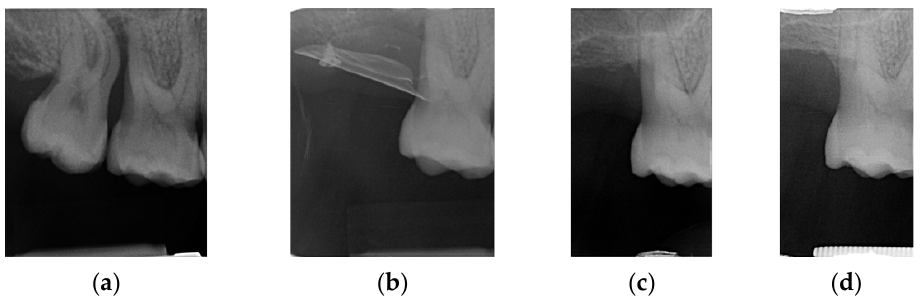
Figure 22. ( a ) Initial periapical radiograph; ( b ) periapical radiograph after foil placement; ( c ) periapical radio-graph after 6 months; ( d ) periapical radiograph after one year.